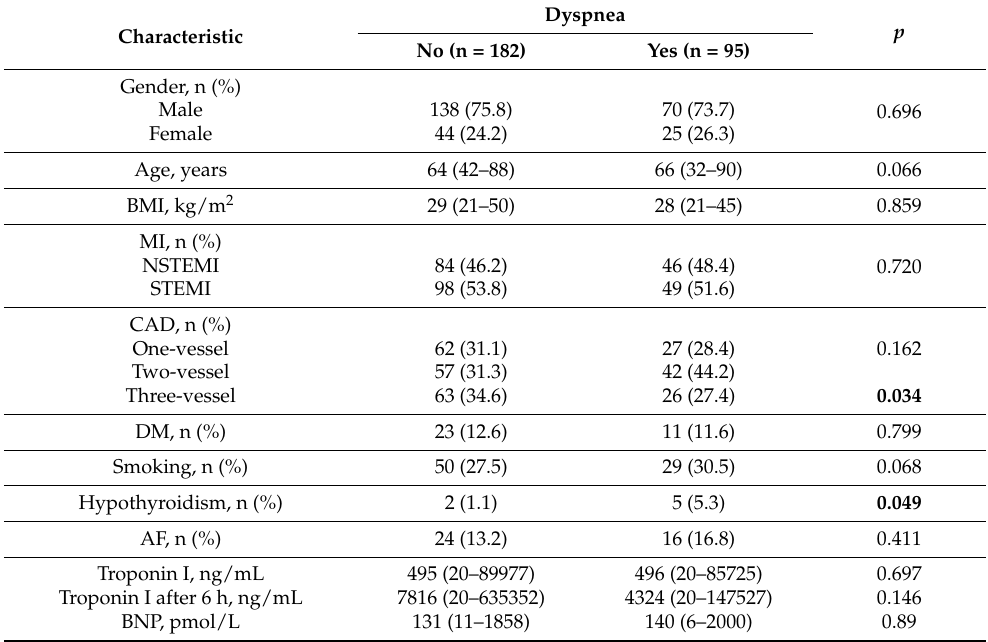
Table 3. Characteristics of the study